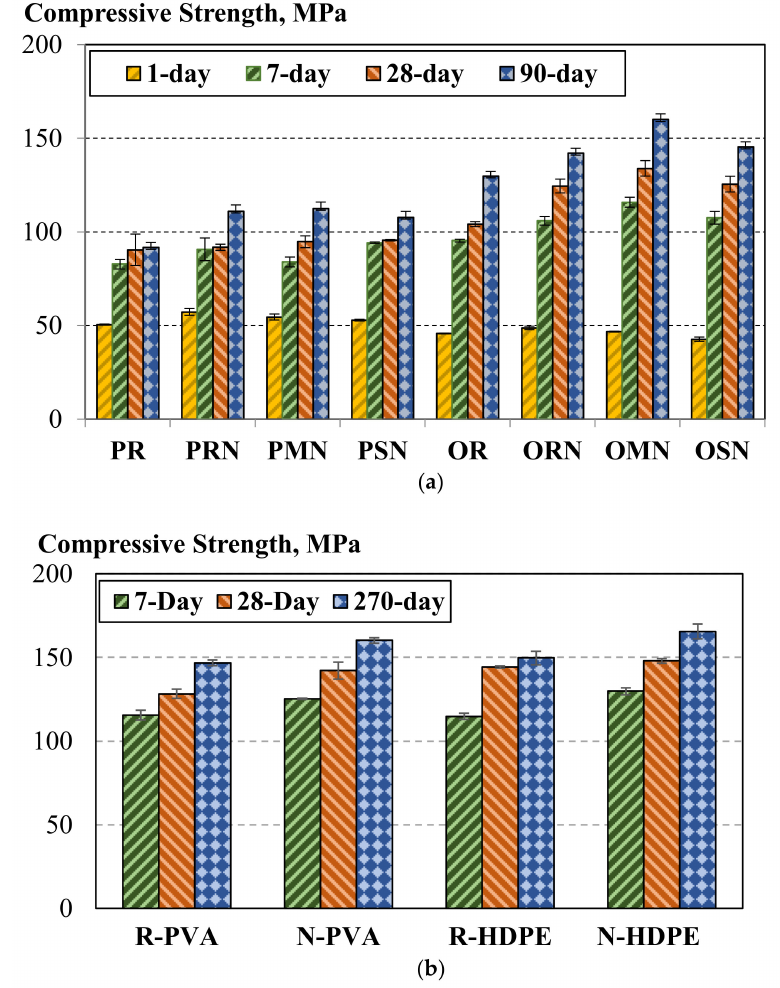
Figure 4. Compressive strength of ( a ) investigated mortars and ( b ) developed fiber-reinforced